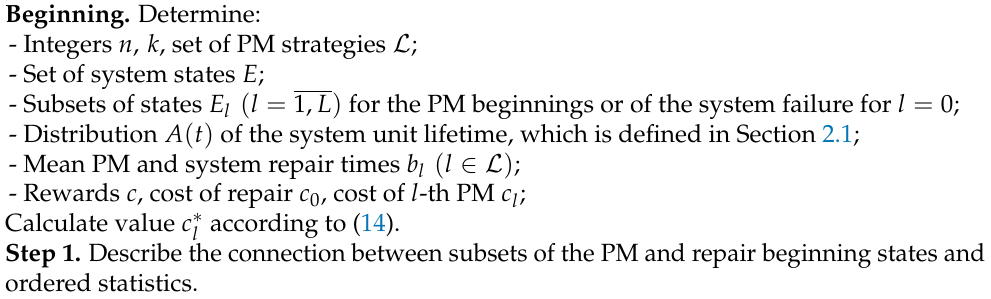
Algorithm 1 The general algorithm for choosing the best